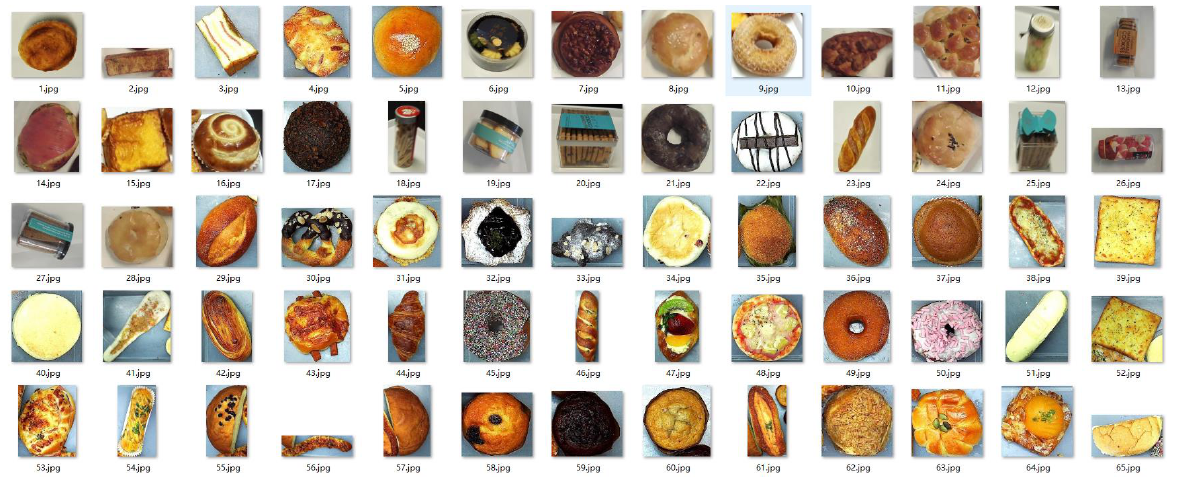
Figure 4. All types of bread